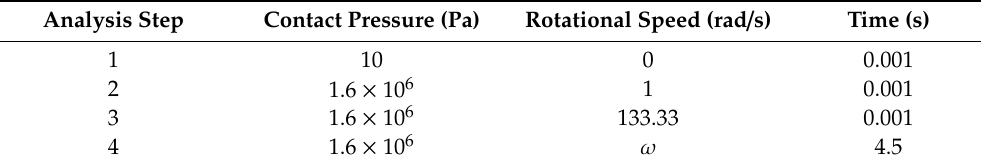
Figure 3. Three-dimensional contact finite element model of brake disc and brake shoe. Table 4. Loading procedure of the finite element analysis. Table 4. Loading procedure of the finite element analysis.